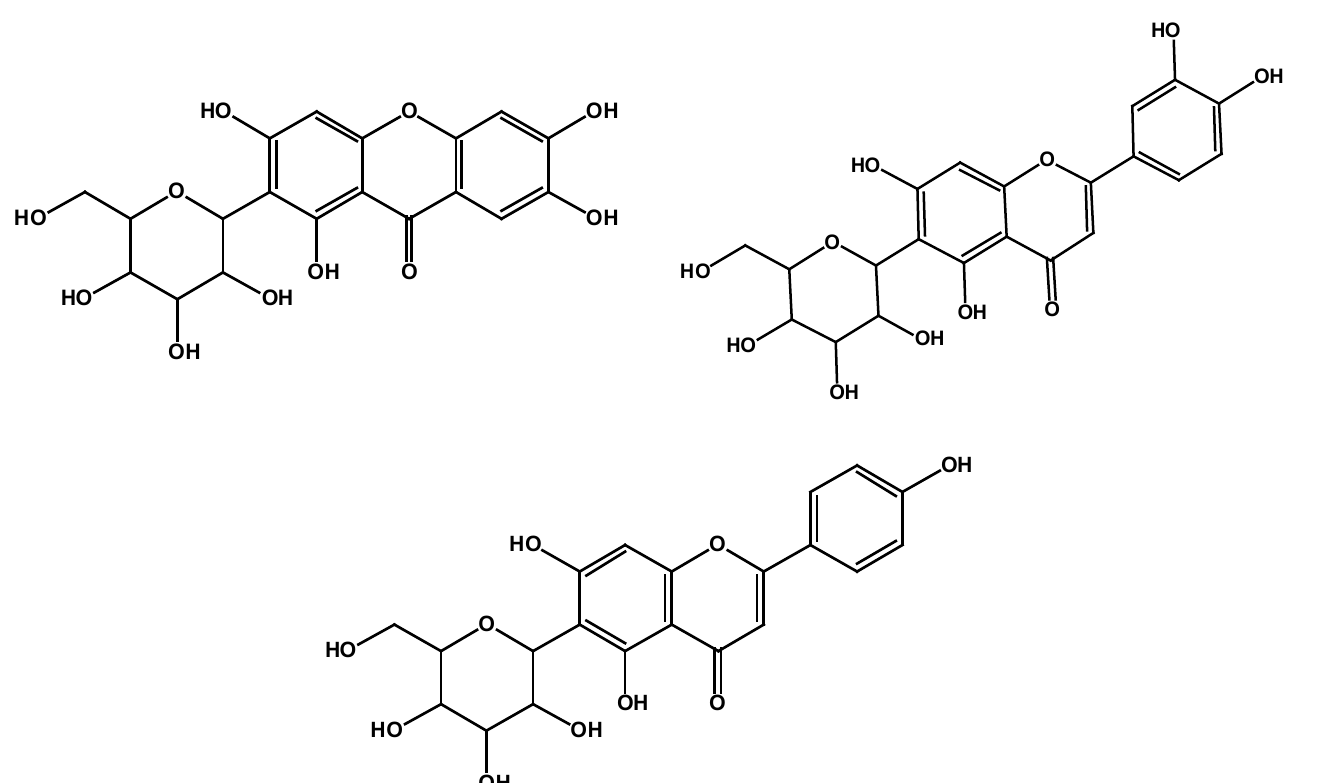
FIGURE 3 – Isolated compounds in ethanolic extract of leaves from the Fridericia